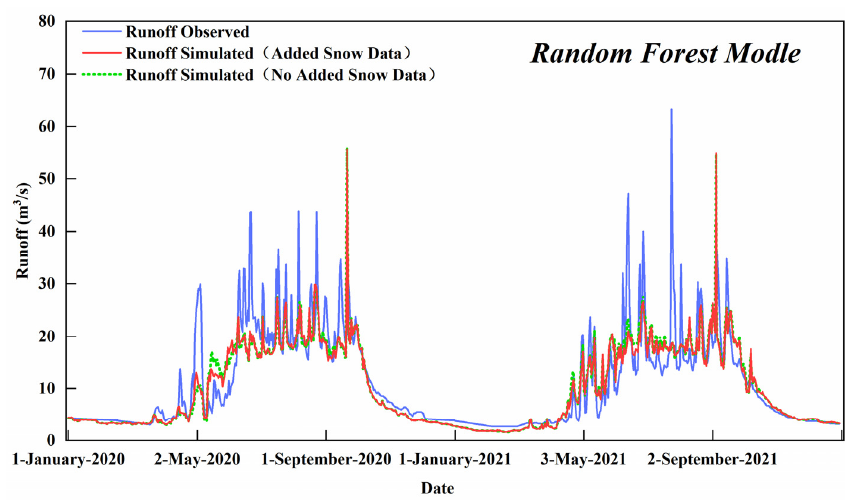
Figure 2. Simulation results for the random forest model of the Xiying River Basin from 2020 to 2021. Table 1. Evaluation parameters for the random forest model of the Xiying River Basin from 2020 to 2021.